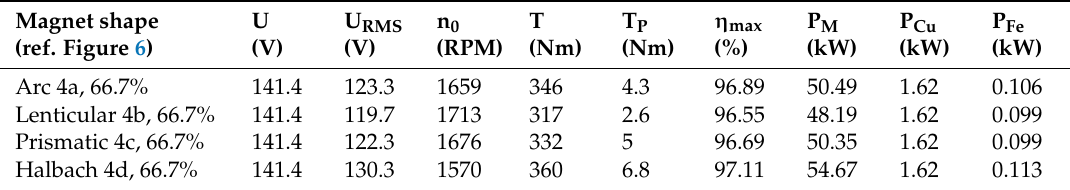
Table 1. The results of initial numerical calculations of the motor with concentrated coils wound with 16 turns of wire with a CSA of 13.4 [mm 2 ].